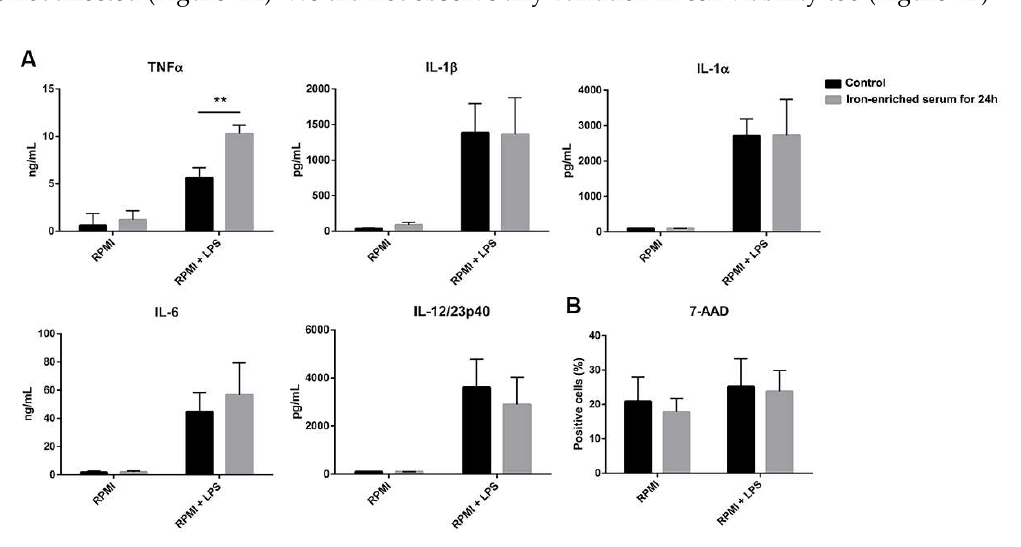
Figure 1. Iron added to culture medium increases the secretion of TNF α by dendritic cells (DCs) exposed for 24 h to LPS (Lipopolysaccharides) ( A ). No difference in cell vitality is observed between the two treatments ( B ) ** p < 0.01 .